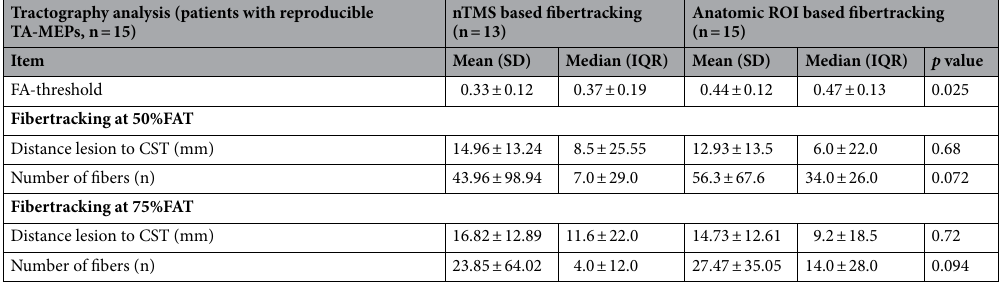
Table 4. Tractography of patients with reproducible TA-MEPs.